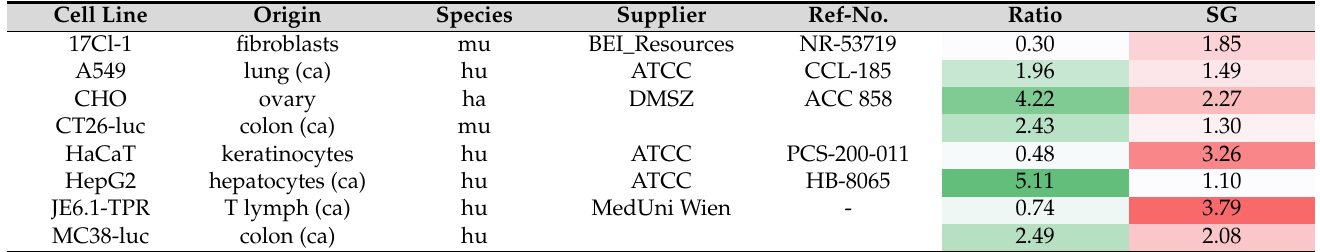
Table 1. Cell lines. Overview of the cell lines, their species and organ origin, supplier, and corre- sponding results from metabolic activity (ratio; color gradient indicates a high (green) or low (white) basal metabolic activity in collagen hydrogels compared to conventional cell culture) and sytox green (SG; color gradient indicates a high (red) or low (white) basal toxicity in collagen hydrogels compared to conventional cell culture) assays. ca = malignant cell line; lymph = lymphocyte; hu = human; Mu = murine; ha = hamster; Ref-No. = reference